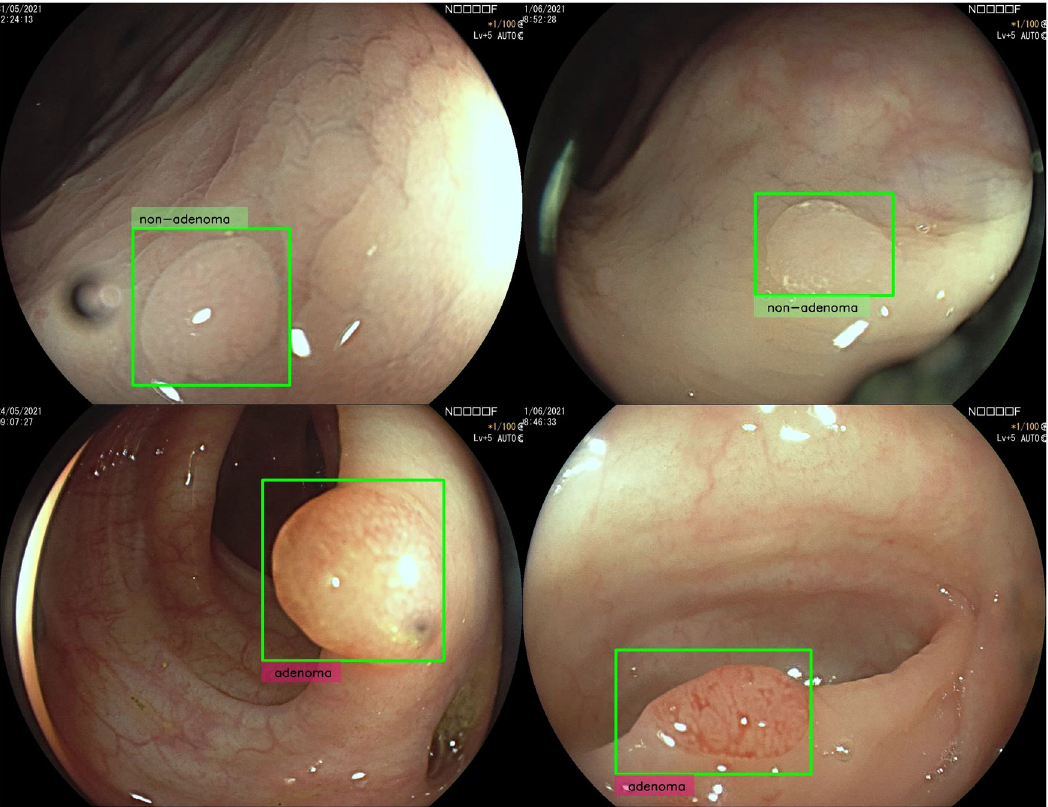
Fig. 4 Exemplar images of polyps with disputed histology. Video frames of polyps for which both CADx and all reviewer predictions are in contrast with the histology ground truth. These polyps are considered false negatives (top row — histology: adenoma, CADx prediction: non- adenoma) or false positives (bottom row — histology: non-adenoma, CADx prediction: adenoma) in the reported